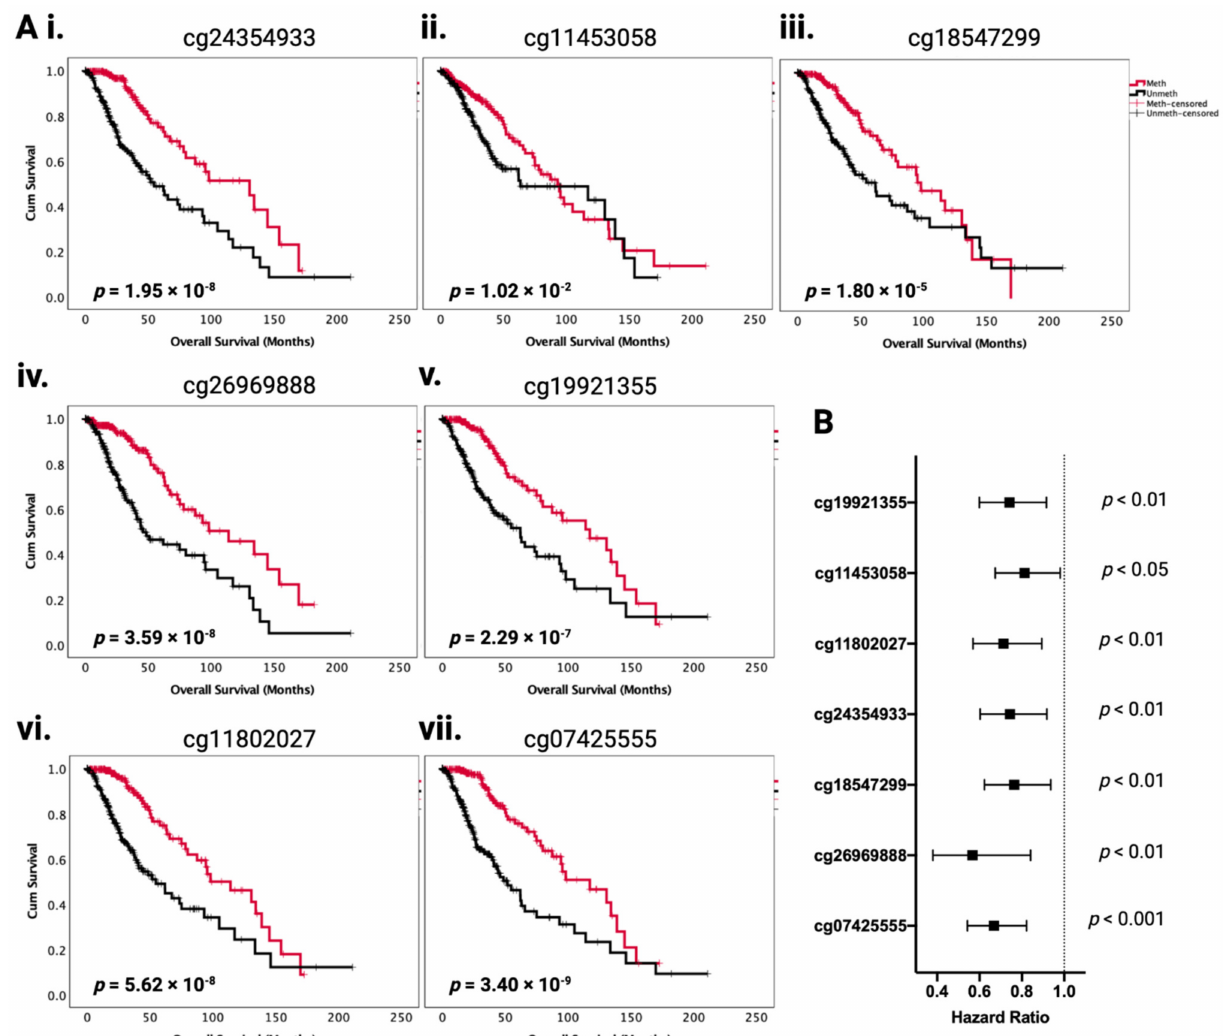
Figure 3. PODNL1 CpG methylation status affects LGG overall survival (OS). ( A ) ( i – vii ). Kaplan–Meier survival curves for LGG OS based on the methylation status of specific PODNL1 CpGs (median beta value cut-off). The red line indicates “Meth” or high methylation group and the black line indicates “Unmeth” or low methylation group. Log-rank p -values are marked in each figure. A p -value of <0.05 was considered significant. Sample numbers n = 254 for each methylation group, for all figures. ( B ) Forest plot of OS multivariate analysis hazard ratios for each significant CpG, after adjusting for age, gender, tumor grade, and IDH1